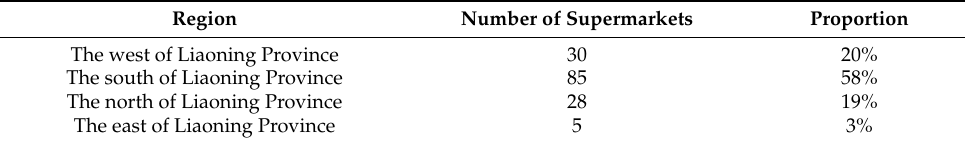
Table 1. Statistics of Regional Proportion of Warehouse Supermarkets in Liaoning Province.